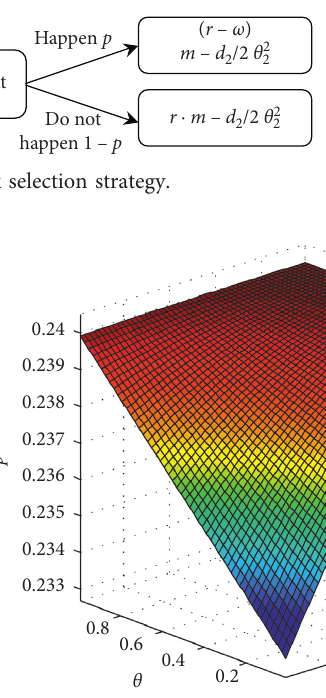
Figure 3: Correlation between the probability of credit default event and CDS loss rate and bank effort θ